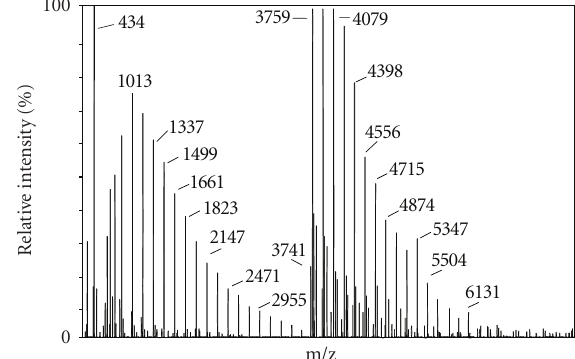
Figure 3: MALDI MS spectrum of a standard solution (1.0mgmL − 1 ) of Frutafit IQ. 3-AQ was used as matrix. Other conditions as reported in Figure 2.